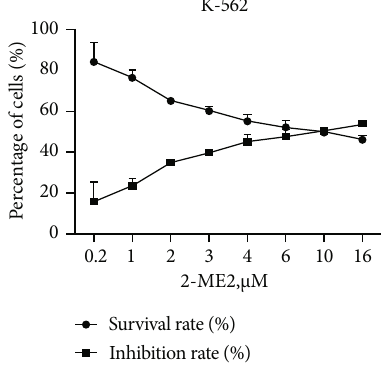
Figure 3: Cell survival rate and inhibition rate of K-562 cells treated with 2-ME2 for 24